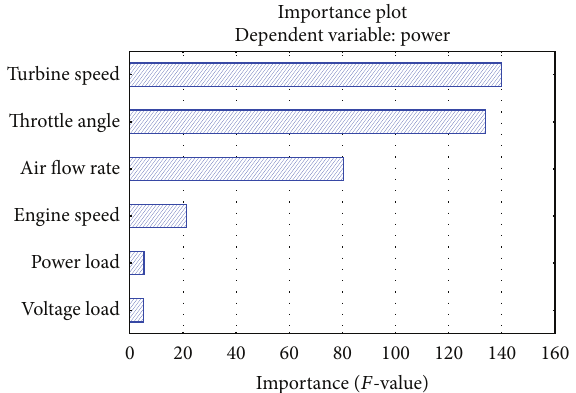
Figure 10: Importance of parameters to power produced as depen- dent parameter.